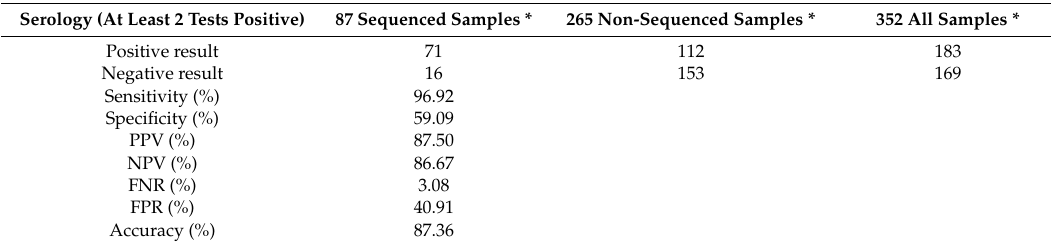
Table 2. Serologic test results. PPV: positive predictive value, NPV: negative predictive value, FNR: false negative rate, FPR: false positive